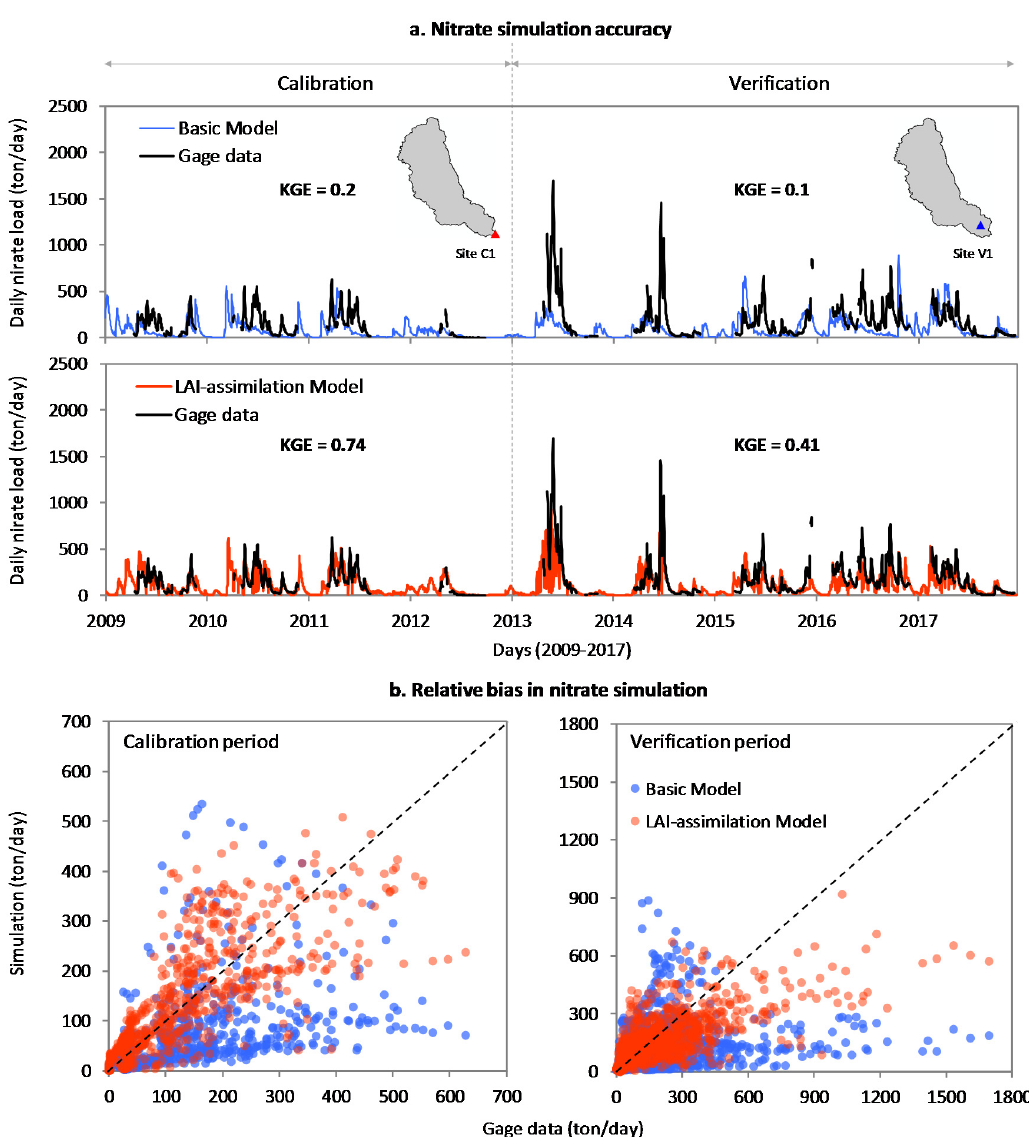
Figure 5. E ff ect of MODIS LAI data on the simulation of daily nitrate loads. ( a ) Improved accuracy as a result of assimilating MODIS LAI data. ( b ) The scatterplot shows the relative change of bias in the basic and LAI assimilation configurations separately for calibration and verification periods. Proximity to the 1:1 line indicates reduced bias relative to gage station in-situ nitrate